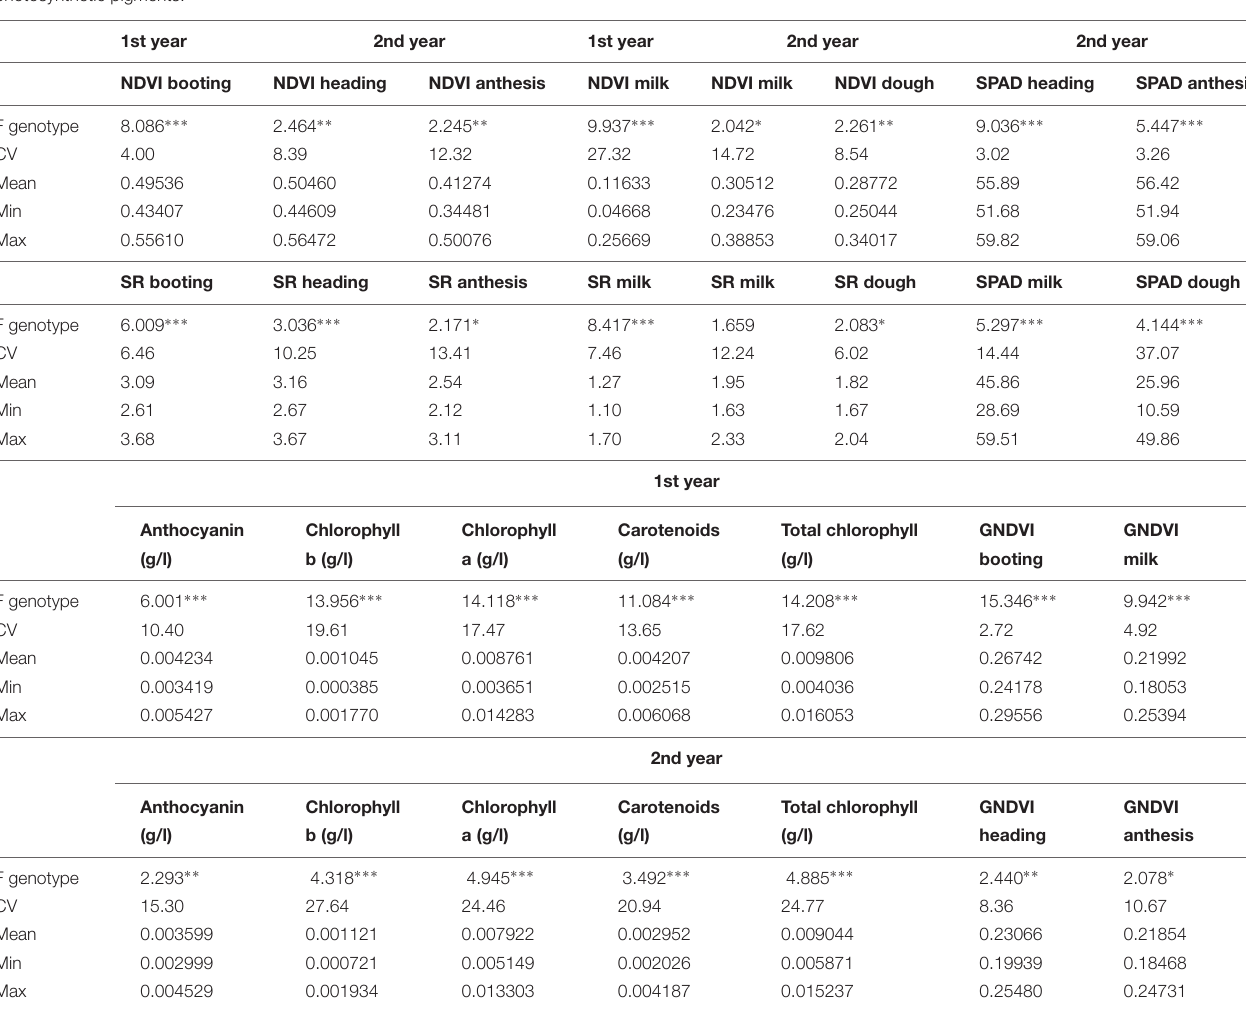
TABLE 3 | Analysis of Variance F -values for genotypes, Coefficients of Variation (CV), means, minimum (Min) and maximum (Max) values for SVIs, SPAD values and photosynthetic pigments.